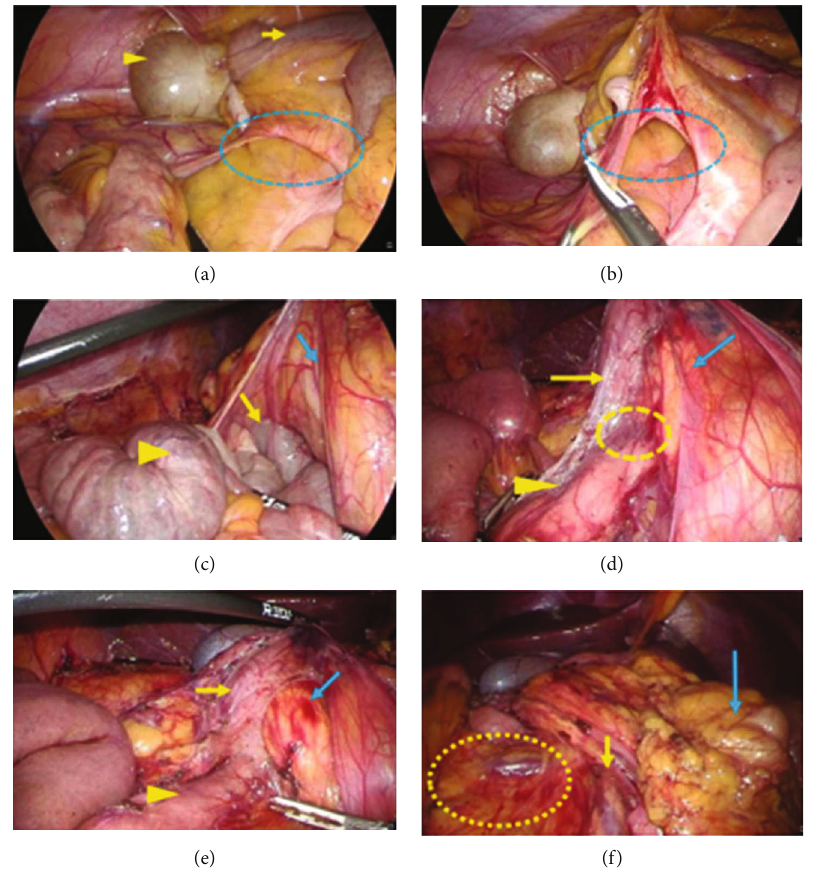
Figure 3: The operative fi ndings in Case 1. (a) The small intestine run through the hernia defect (dotted area), which consists of the fi brotic adhesions between the retroperitoneum and the colon mesentery. Cecum (arrowhead) and terminal ileum (arrow) were recognized over the hernia gate. (b) The hernia defect (dotted area) was dissected. (c) The outside adhesion of the right colon and the abnormal retroperitoneal bands was also dissected. After that, the duodenum (yellow arrow) and the jejunum (yellow arrowhead) were recognized under the ascending colon (blue arrow). (d) There was a severe curve (dotted area) at the transition from the proximal side of the duodenum (yellow arrow) to the distal side (yellow arrowhead), and a membrane structure ran across the duodenum and the pancreas head (blue arrow). (e) The transition between the proximal side of the duodenum (yellow arrow) and the distal side (yellow arrowhead) was straightened. The bleeding was recognized at the pancreatic head (blue arrow). (f) The small intestinal mesentery (dotted area) was recognized at the right side, and the transverse colon (blue arrow) was at the left side. The root of the small intestinal mesentery (yellow arrow) was fully widened.